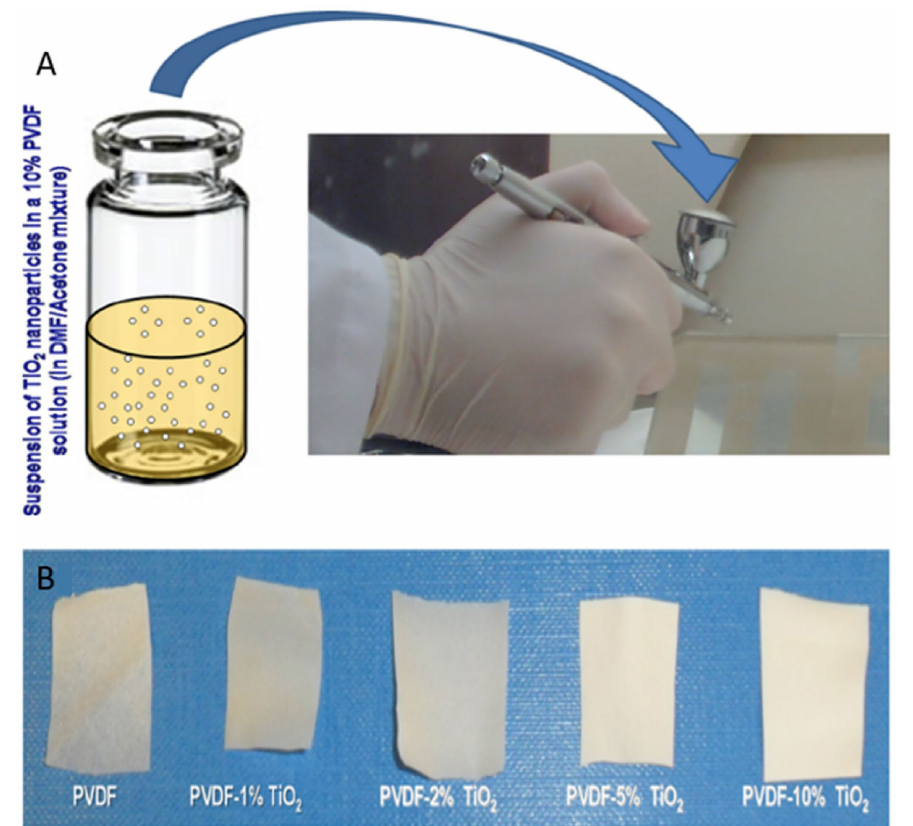
Figure 2. ( A,B ) Solution blow spinning was used to prepare nanocomposites based on PVDF filled with well-dispersed titanium dioxide nanoparticles for antibacterial activity. Figure reproduced with permission of the publisher, 2016, Elsevier [43].